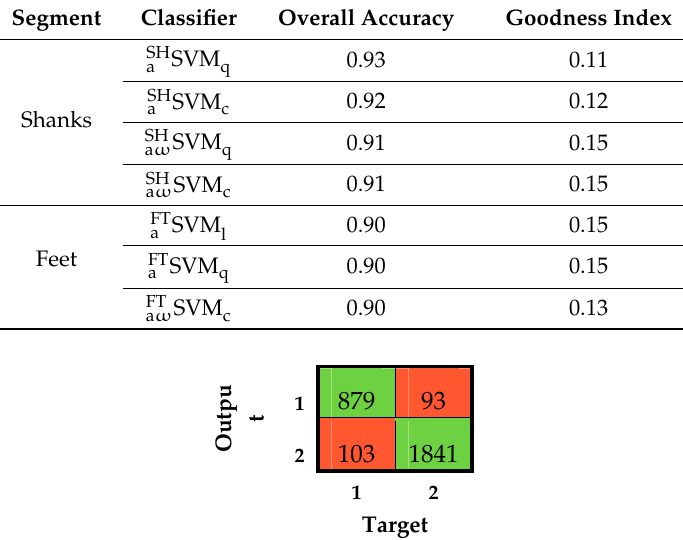
Figure 8. Confusion matrix related to the simplified SH a SVM q considering all subjects together. 1 and 2 stand for regular and irregular race walking, respectively. Numbers in green cells represent the correct classifications, while those in red cells are misclassifications.